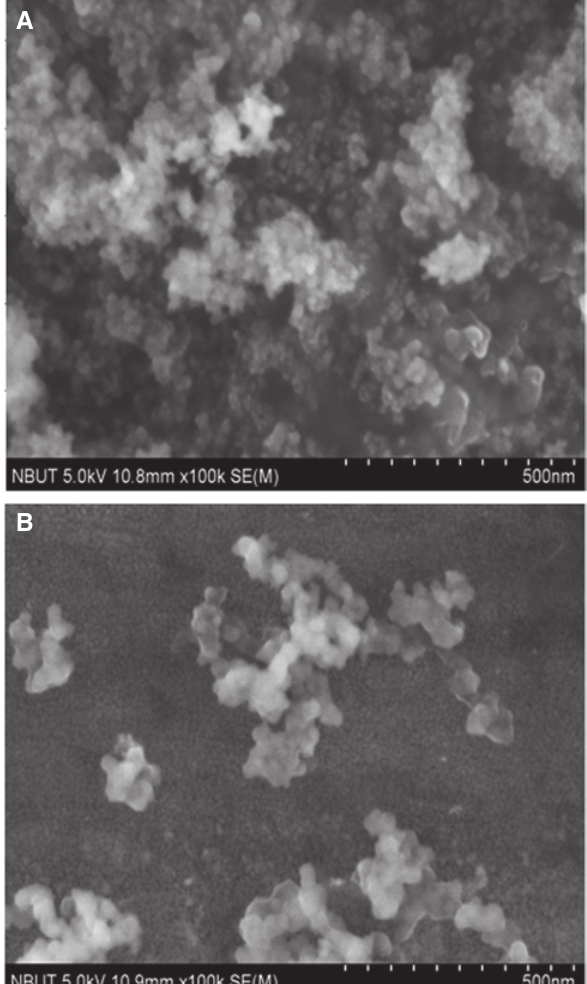
Figure 2 SEM of nanosilica. (A) Unmodified. (B) Modified with KH570.